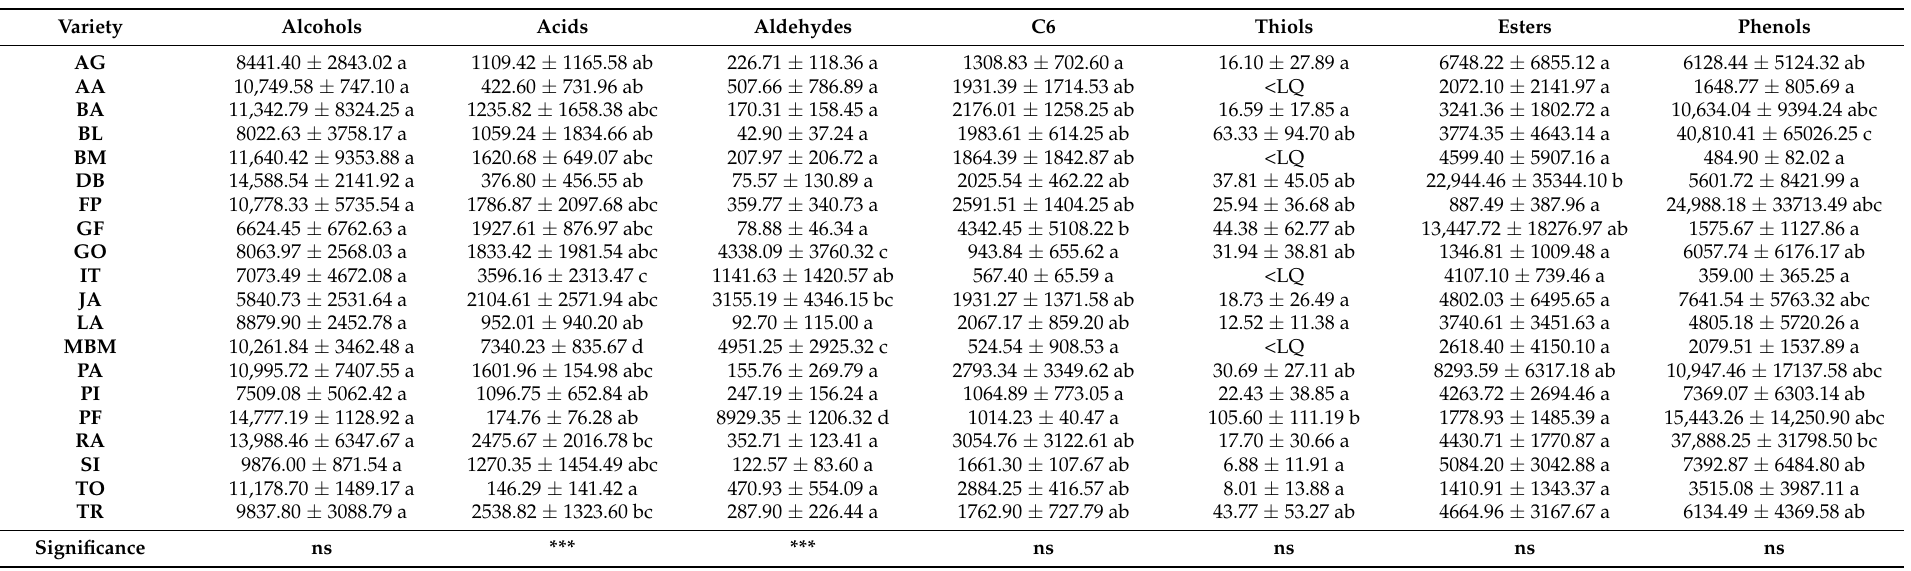
Table 3. Glicosidically bound fraction (all values are expressed as µ g · L − 1 to allow for comparisons among